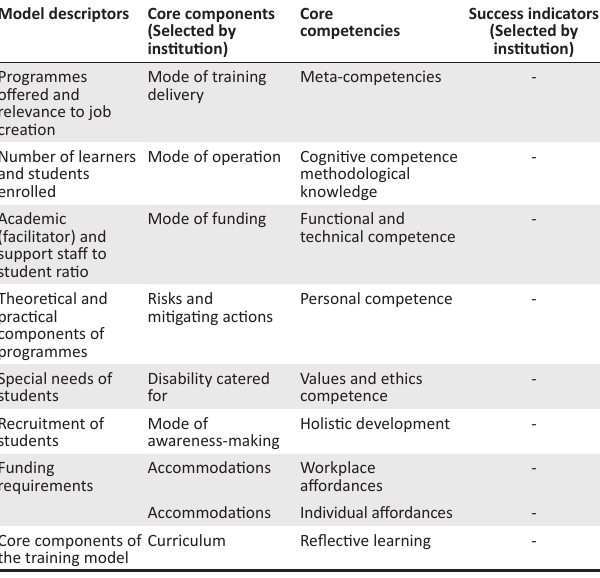
TABLE 1: Basic components of the Adaptable Component-based Assessment